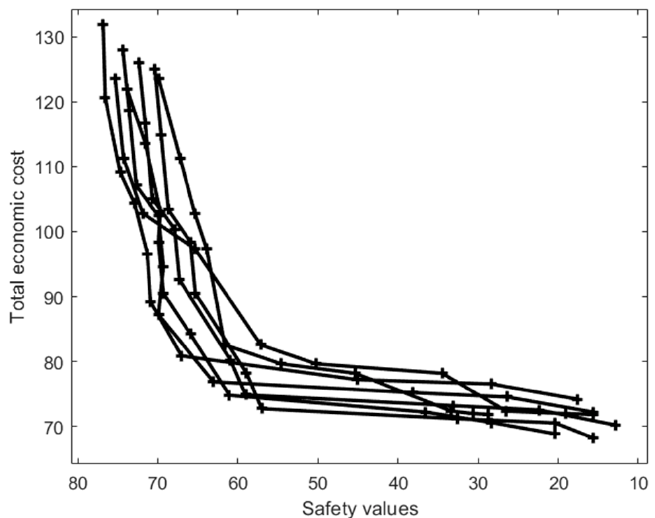
Figure 6. Plot of the initial solution distribution under the dual objective.